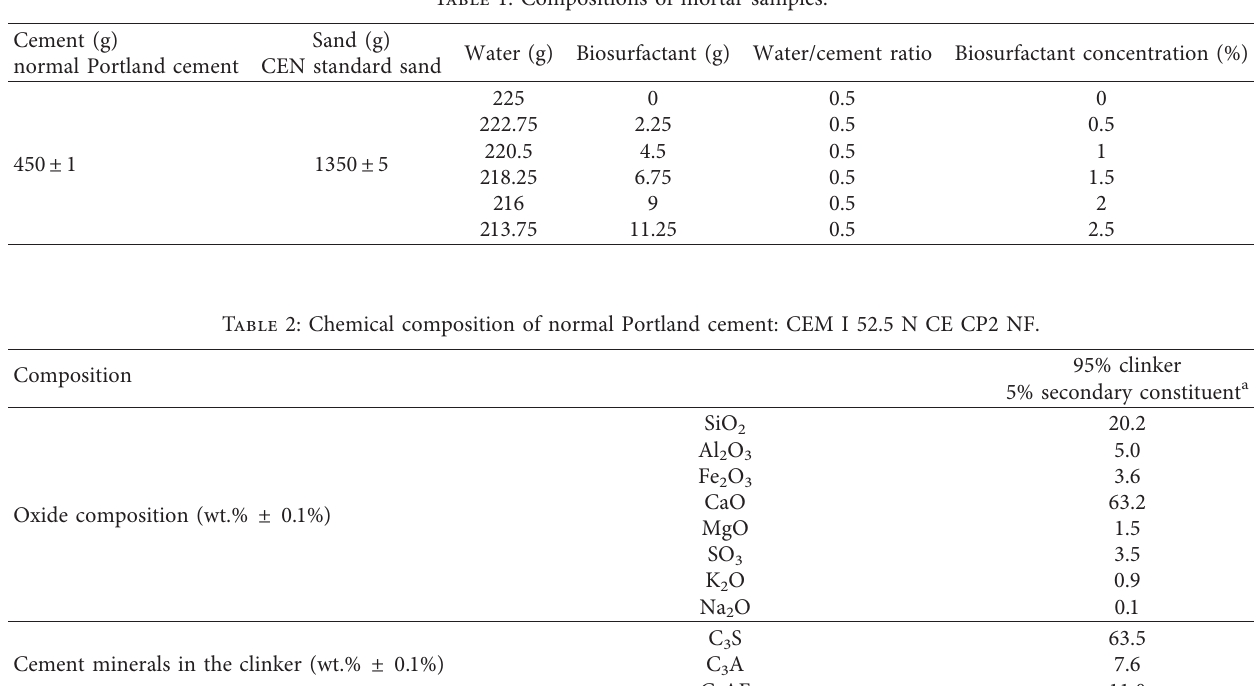
Table 1: Compositions of mortar samples.